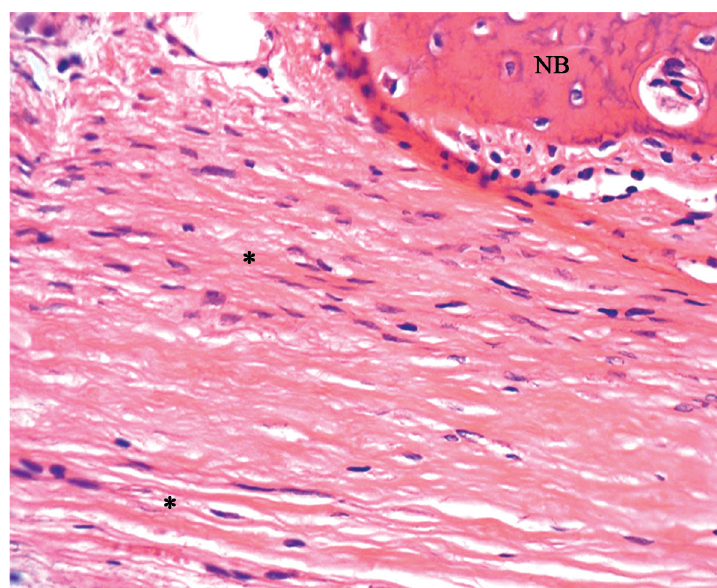
Figure 4- Group PBMT: Dense connective tissue, with parallel fibers (*) and newly formed bone tissue (NB)